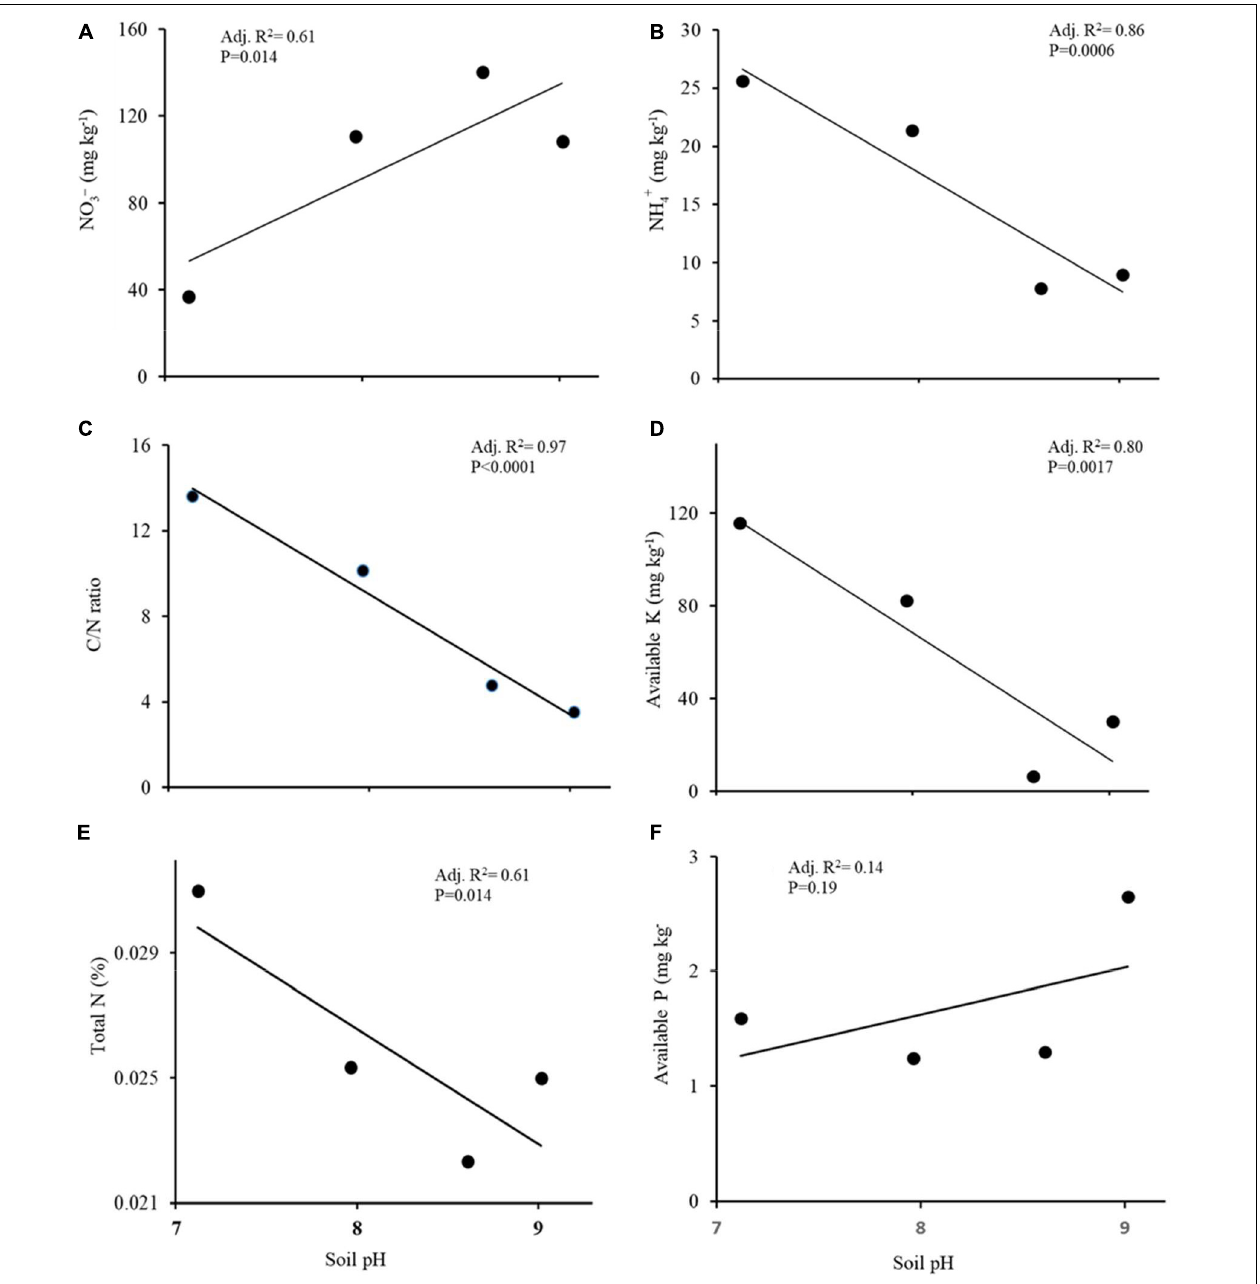
FIGURE 2 | Relationship between selected soil nutrients and soil pH: (A) NO 3 − ; (B) NH 4 + ; (C) C:N ratio; (D) available K; (E) total N and (F) available P. Adjusted coefficient of determination of the regression (Adj. R 2 ), and its associated probability (P).